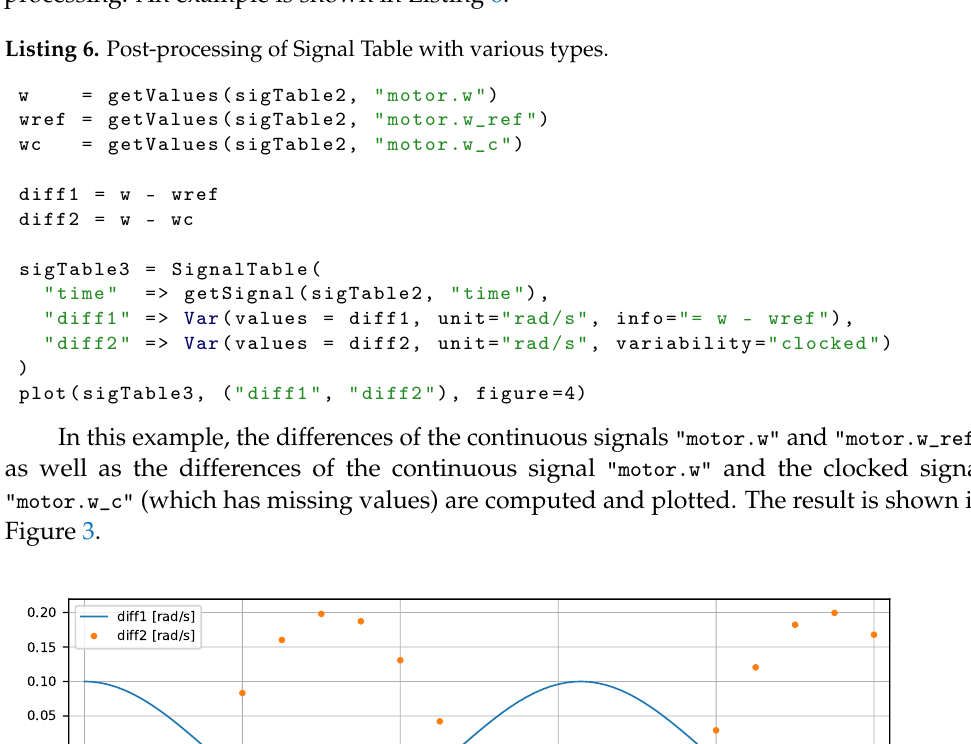
Figure 2. Plot of Signal Table with various types. In the first plot, the continuous signal "motor.w" and the clocked signal "motor.w_c" are shown. As missing values are ignored in a plot, the missing values of "motor.w_c" are not shown. The second plot(..) call has the signal "baseClock" as the x-axis, thus, an integer vector with the numbers 1,2,...,21 of the clock ticks. Because signal values are arrays, array operations can be conveniently used for post- processing. An example is shown in Listing 6.